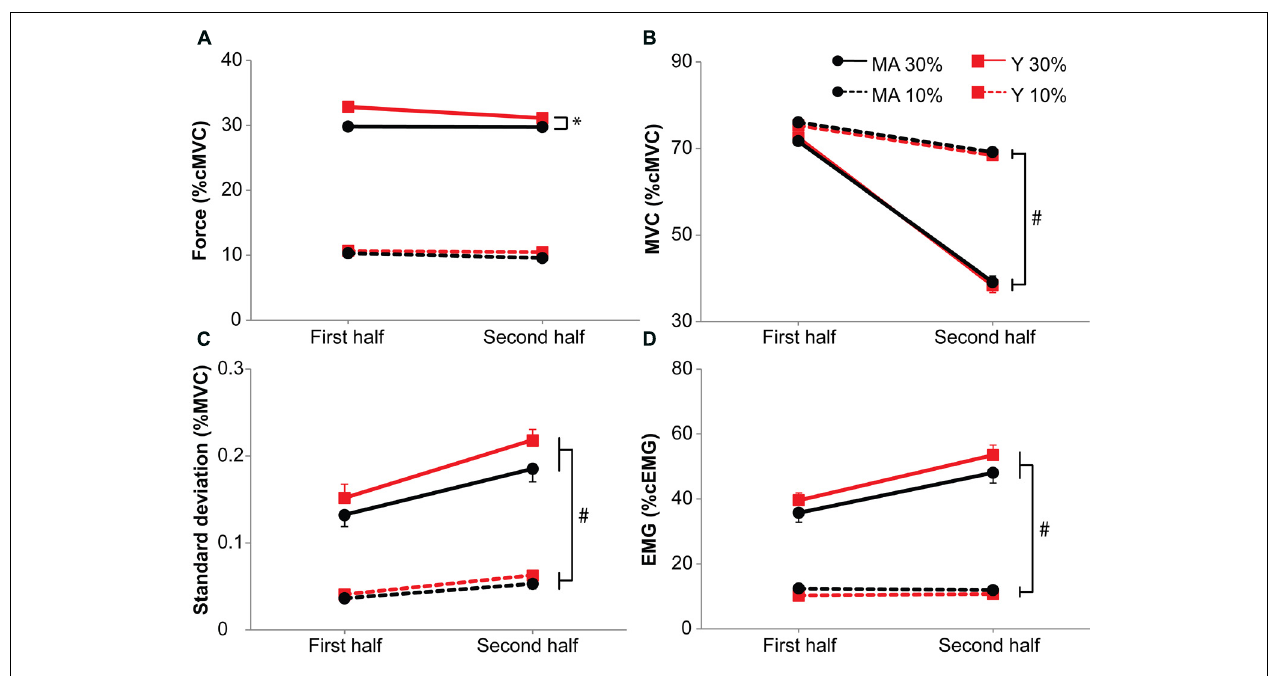
for 10%-dual-task. Error bars represent SE. * Shows main effects, # shows interaction effects. Signs of fatigue in the second half of the dual task are clearly visible for the 30%-dual-task (i.e., decline in MVC, increase in the standard deviation of the submaximal force associated with an increase in